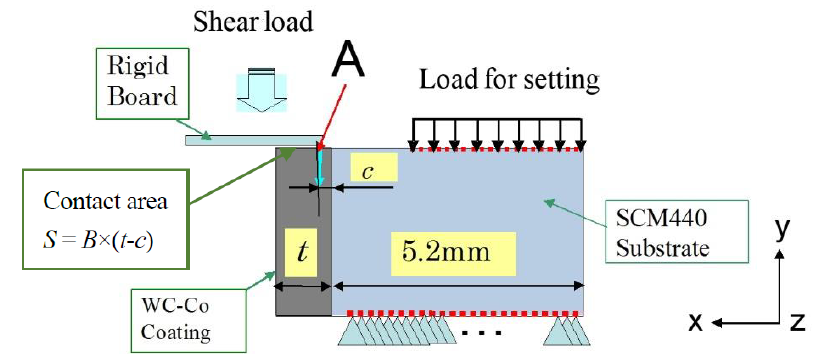
Figure 11. FEM model of the scraping test